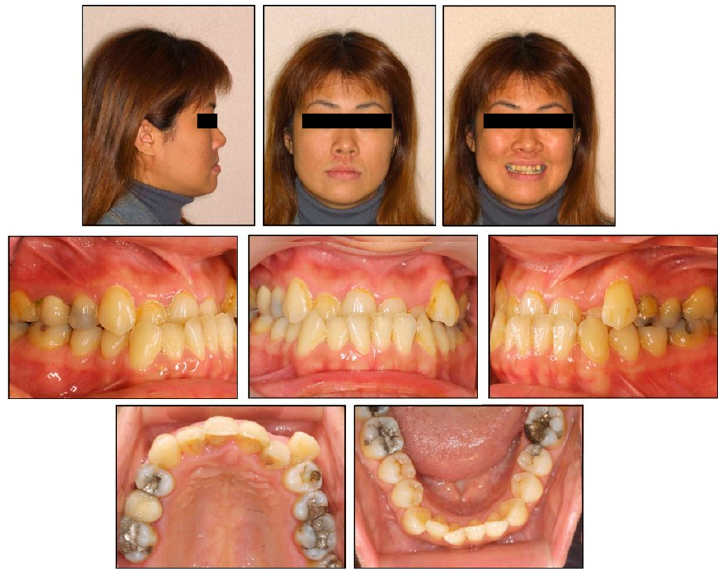
Figure 9. Case 2, Pretreatment facial and intraoral photographs.